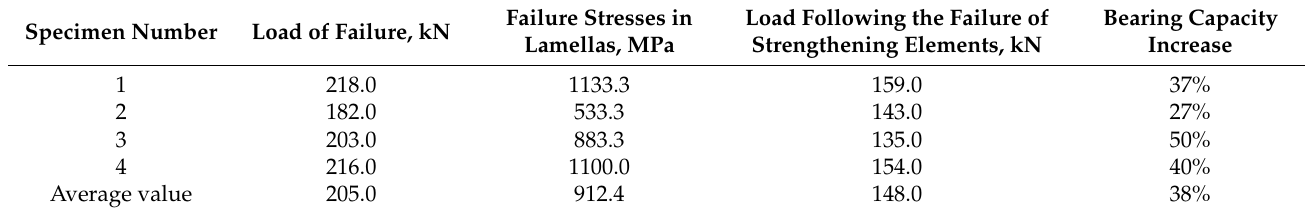
Table 5. The testing of CFPR specimens.